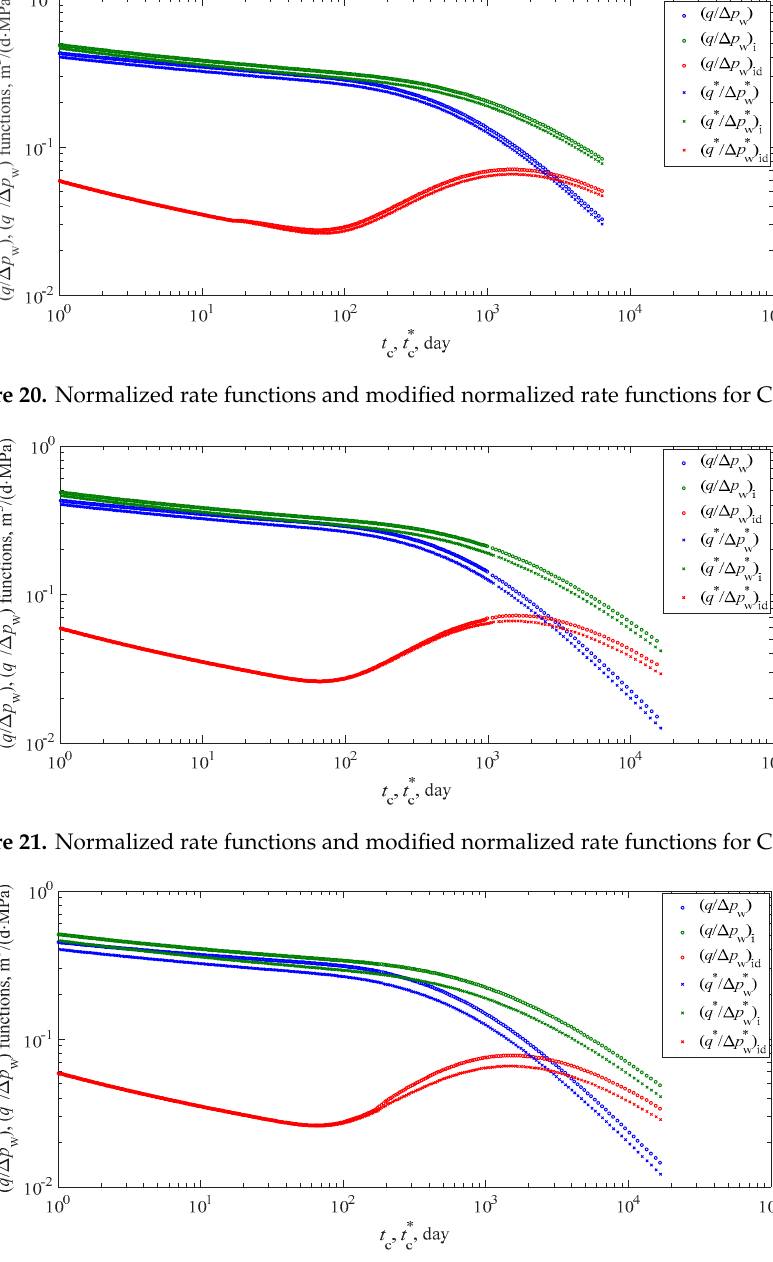
Figure 19. Production data for Case 4 with variable rate and pressure.